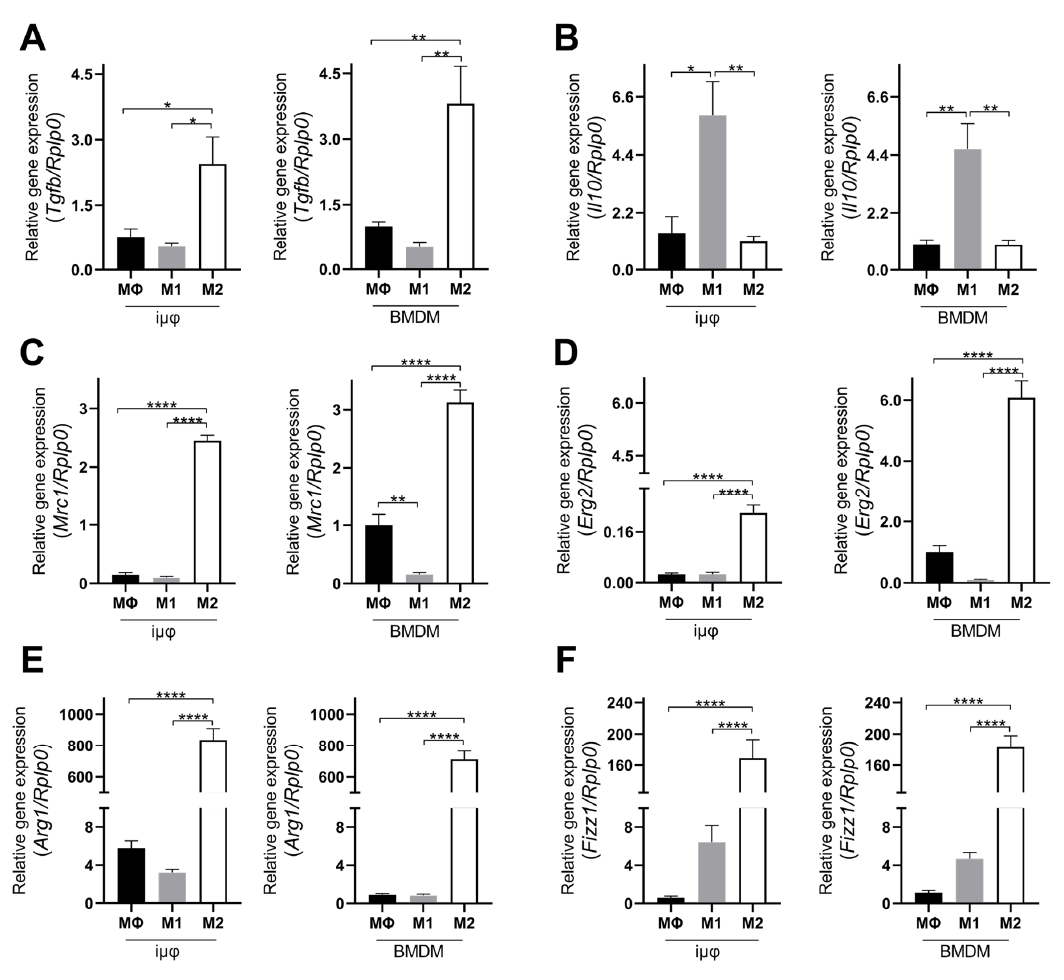
Figure 2. Alternatively (M2) stimulated immortalized murine macrophages (i µ φ ) and BMDMs display similar phenotypical features. qRT-PCR quantification of Tgfb ( A ), Il10 ( B ), Mrc1 ( C ), Erg2 ( D ), Arg1 ( E ) and Fizz1 ( F ), specific genes in resting (M Φ ), M1- and M2-stimulated i µ Φ macrophages ( n = 3) and in BMDM macrophages ( n = 3). Data are means ± SEM. * p < 0.05, ** p < 0.01, **** p < 0.0001.